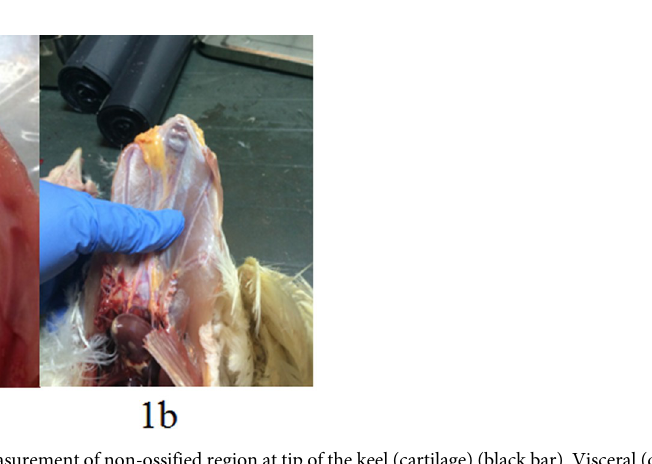
Fig 1. a: Illustration of measurement of non-ossified region at tip of the keel (cartilage) (black bar). Visceral (dorsal) aspect of the keel bone plate and b: typical location of fractures and with substantial callus formation.